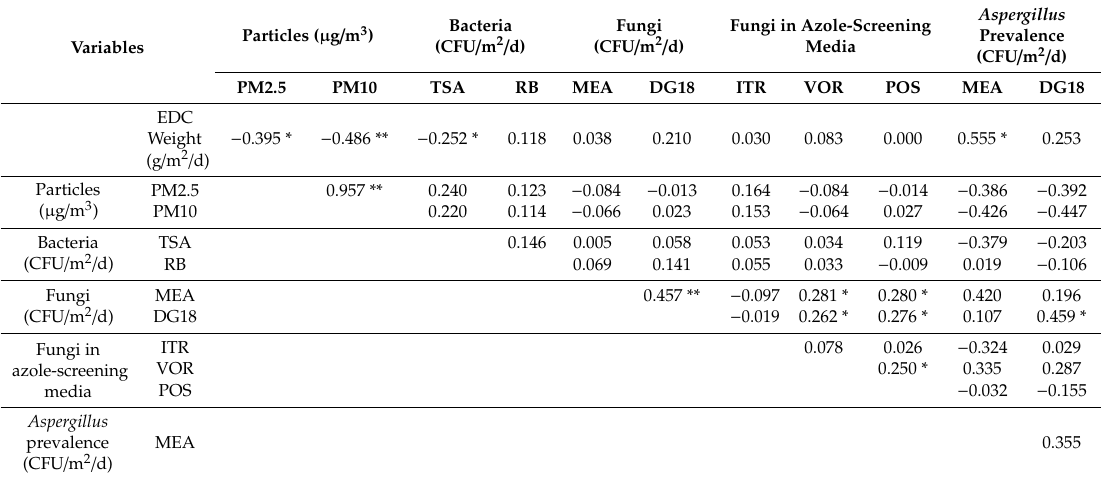
Table 6. Study of the relationship between the weight of EDCs, particulate matter (PM2.5 and PM10), bacterial (TSA and VRBA) and fungal (MEA and DG18) contamination, fungi in azole-screening media (ITR, VOR and POS) and Aspergillus prevalence (MEA and